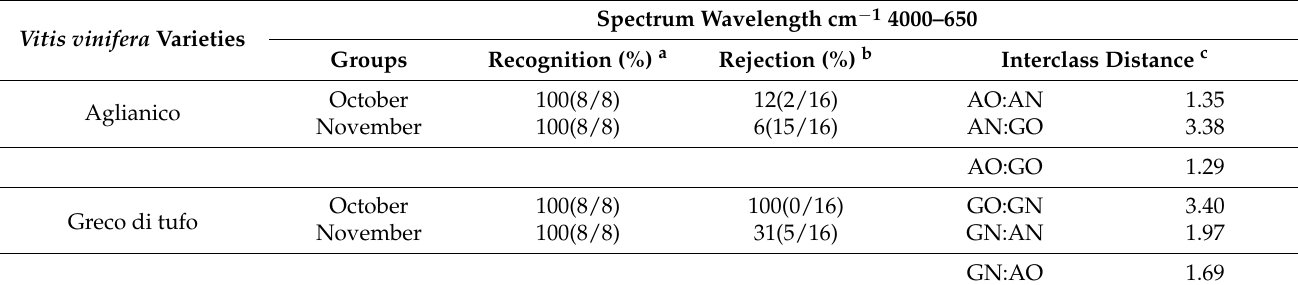
Table 6. Interclass distance of V. vinifera extratcs of leaves of ‘Aglianico’ harvested in October (AO), ‘Aglianico’ harvested in November (AN), Greco di Tufo harvested in October (GO) and ‘Greco di Tufo’ harvested in November (GN). Vitis vinifera